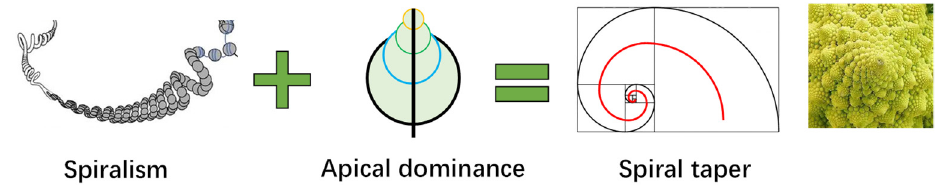
Figure 7. Formation mechanism of spiral taper and the expressions on various organisms.